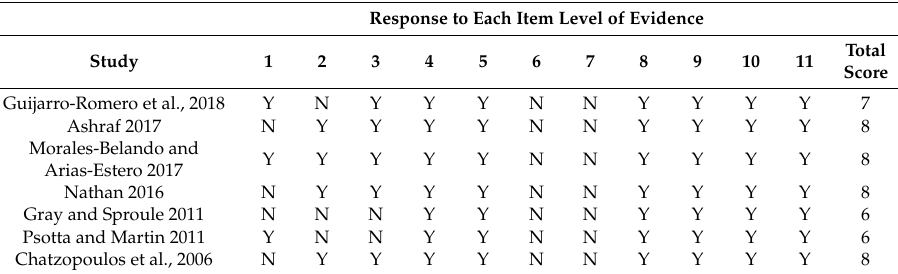
Table 1. Risk of bias according to the PEDro